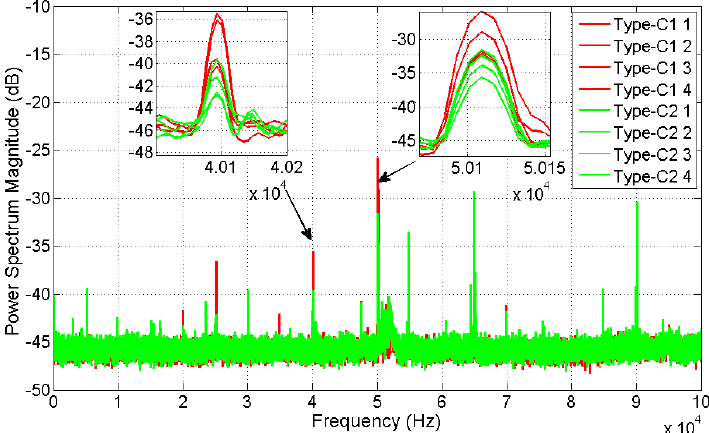
Figure 9. Power spectrum of response of type-C1 and -C2 slab tested following procedure P2. Evidence that the damage level is only slightly short of being detectable at 40 and 50 KHz is given in insets.